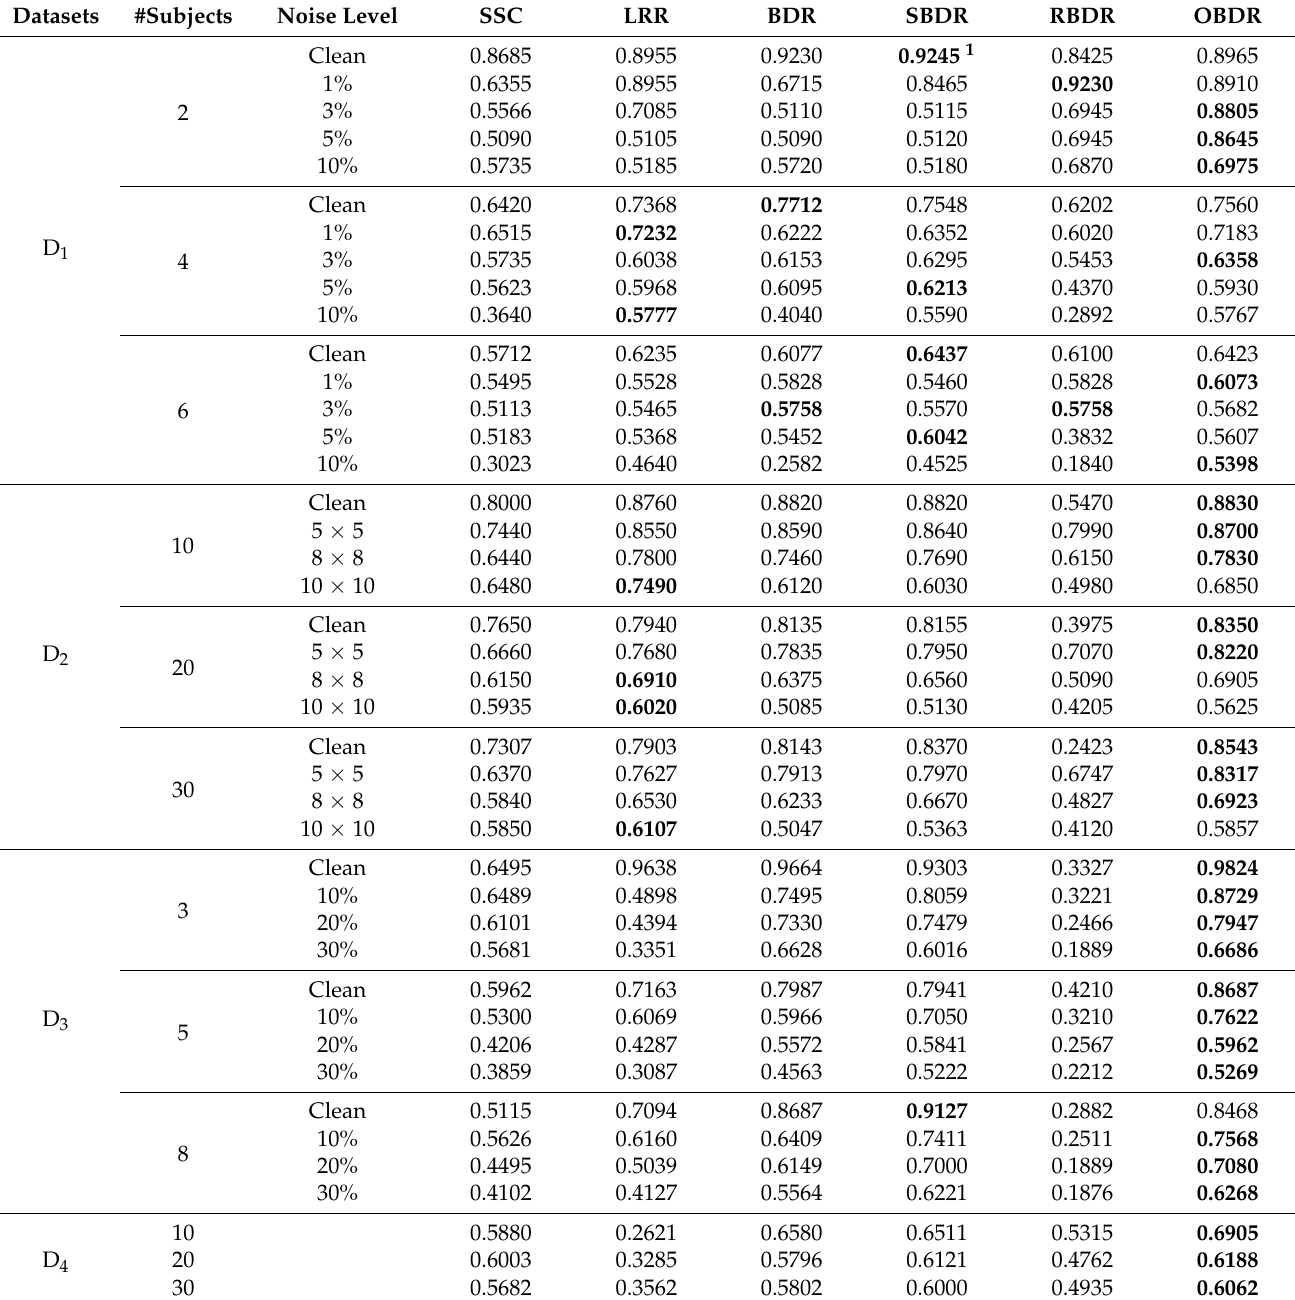
Table 3. ACCs of algorithms on